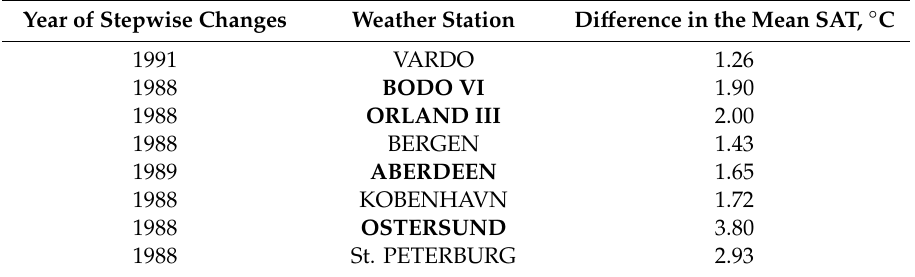
Table 3. Assessment of the warming in Northern Europe based on the divided trends (1951–2016 period, January). The weather stations with the bold font are those with ∆ step ≥ 10%. Difference in the mean Year of stepwise changes Weather station SAT, °C